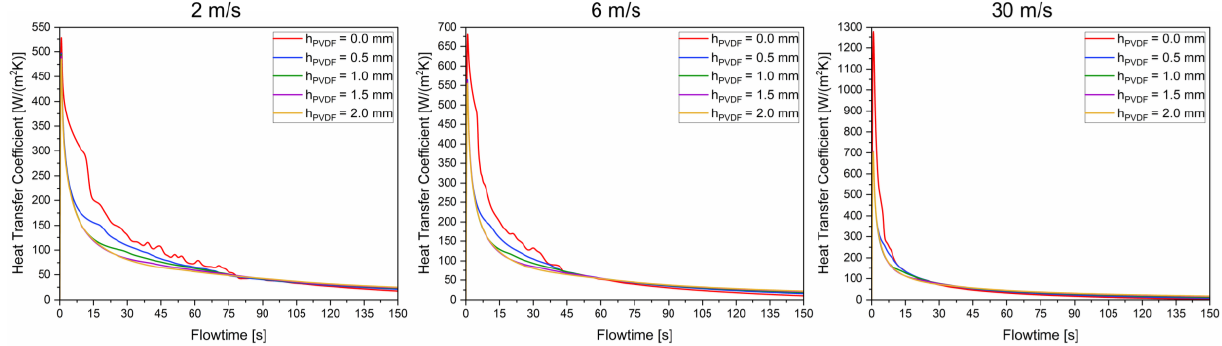
Figure 7. Heat transfer coefficient in dependence of inflow velocity and shell thickness.